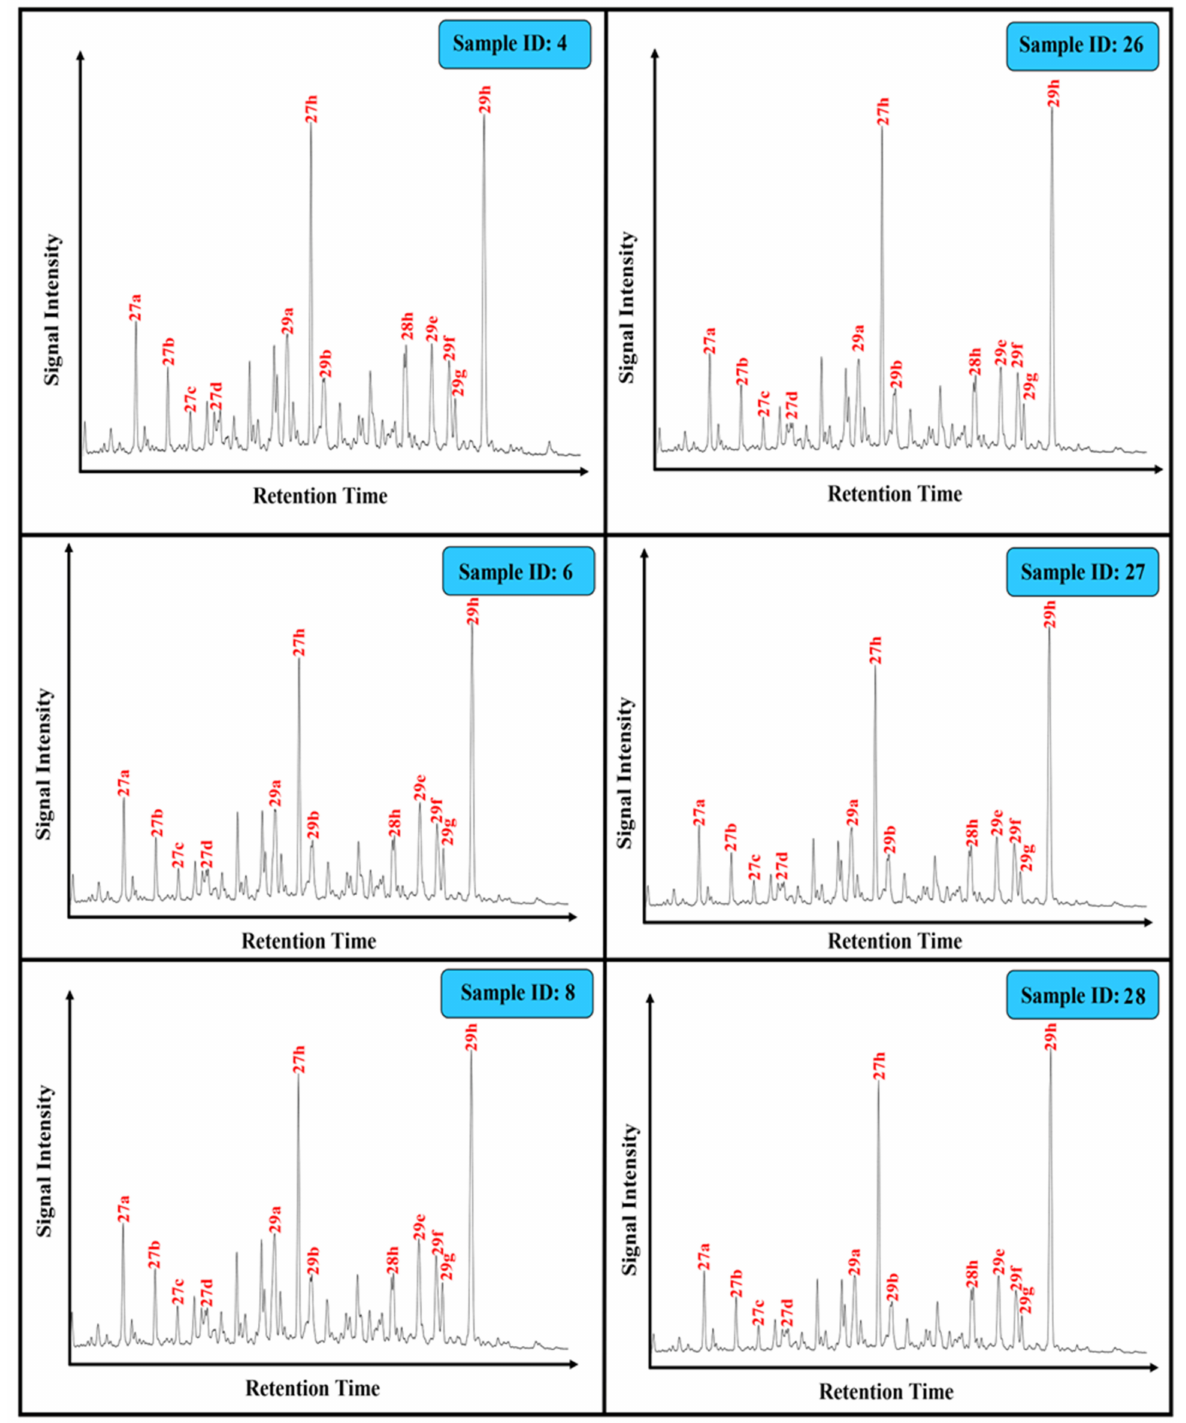
Figure 8. m/z 217 mass fragmentograms of the aliphatic hydrocarbon fraction in the analyzed shales of the Qusaiba